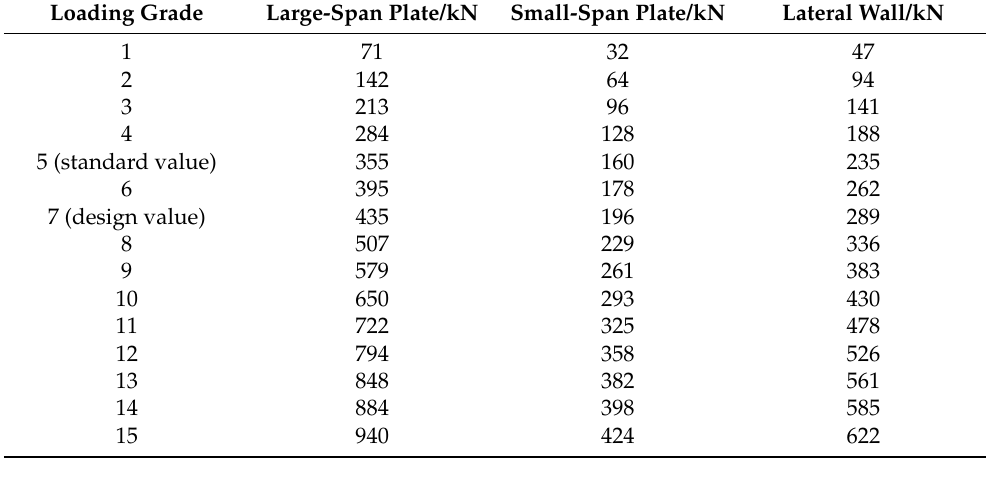
Table 2. Test loading procedure.